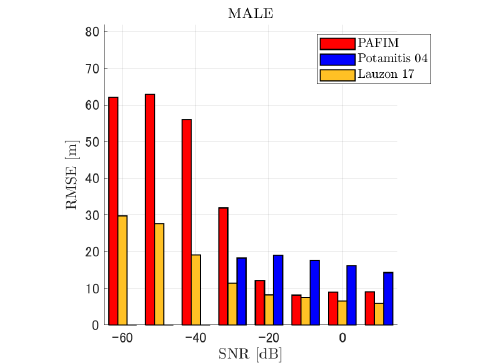
Figure 18. RMSE of tracking a randomly moving sound source emitting male voice (focusing on source horizontal distance = 30 m). Tracking results of Potamitis’s method did not converged when the SNR is less than − 40 dB.